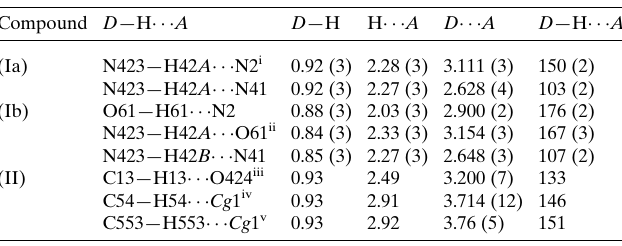
Table 1 Hydrogen bonds and short inter- and intramolecular contacts (A˚ , (cid:3) ). Cg 1 represents the centroid of the C11–C16 ring. Compound D —H (cid:2)(cid:2)(cid:2) A